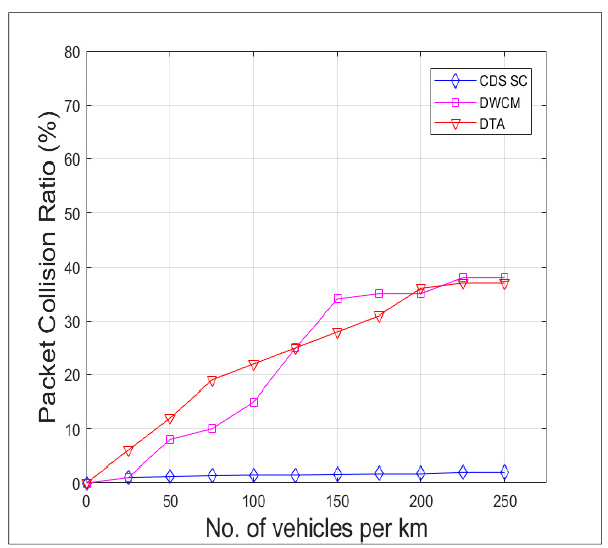
Figure 16. Packet collision ratio versus vehicle density.